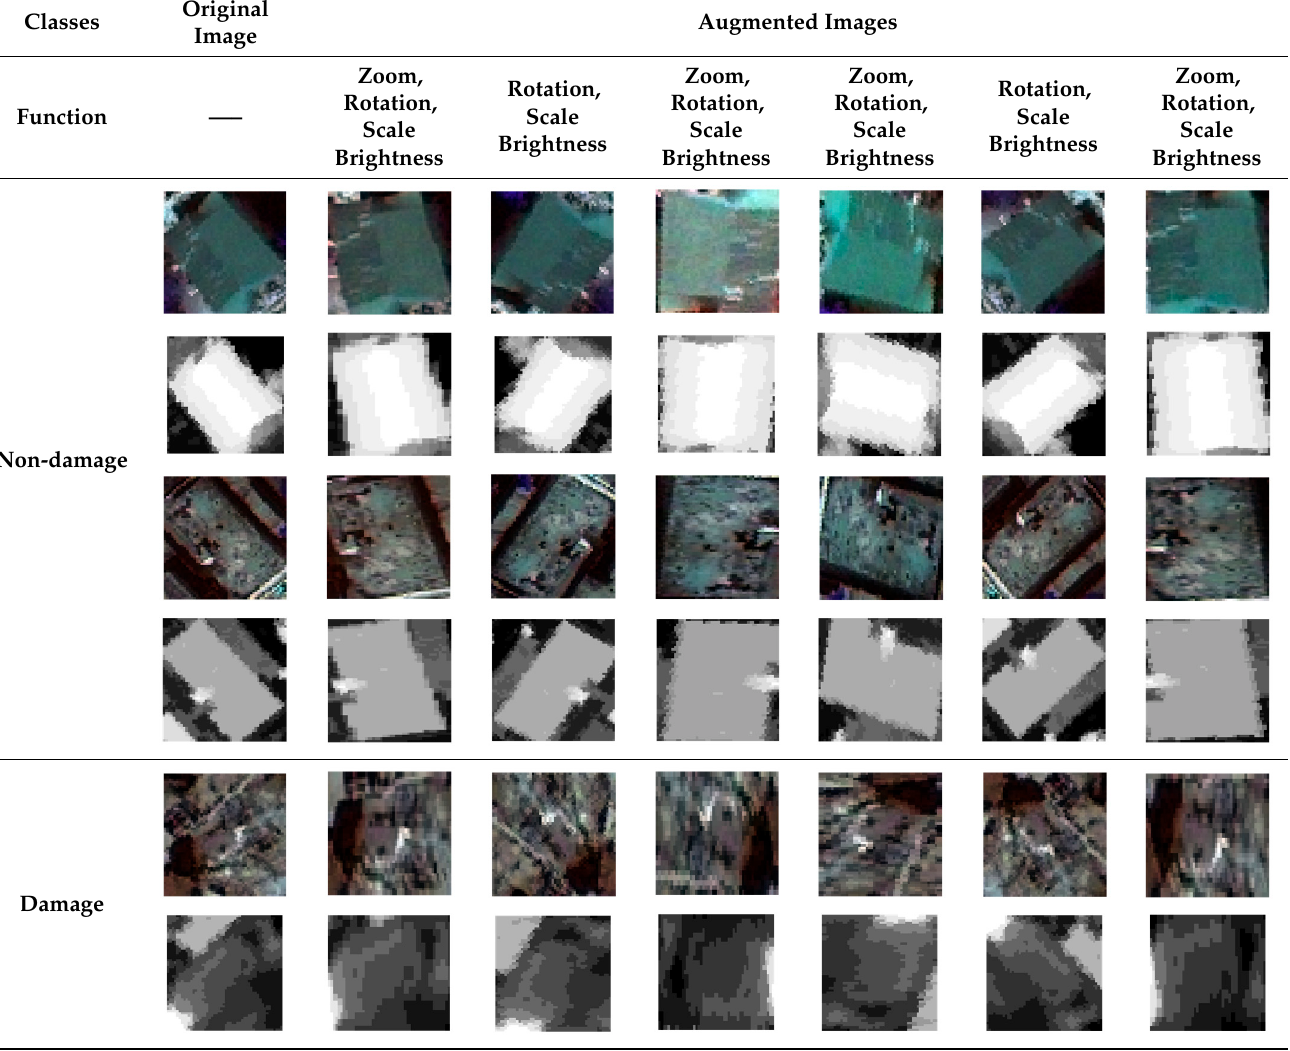
Table 3. Example of data augmentation.